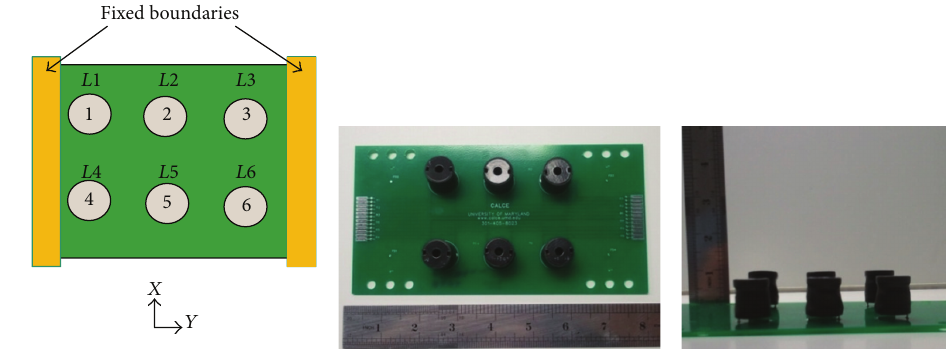
Figure 10: CCA with six large inductors, dimensions are in inches.